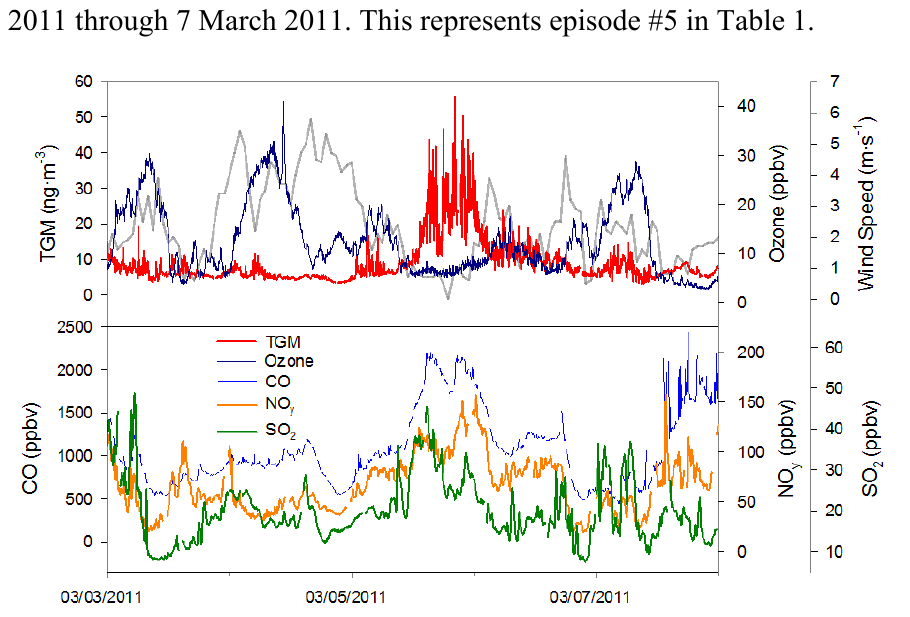
, CO, NO , SO , and wind speed (gray) over the period 3 y 2